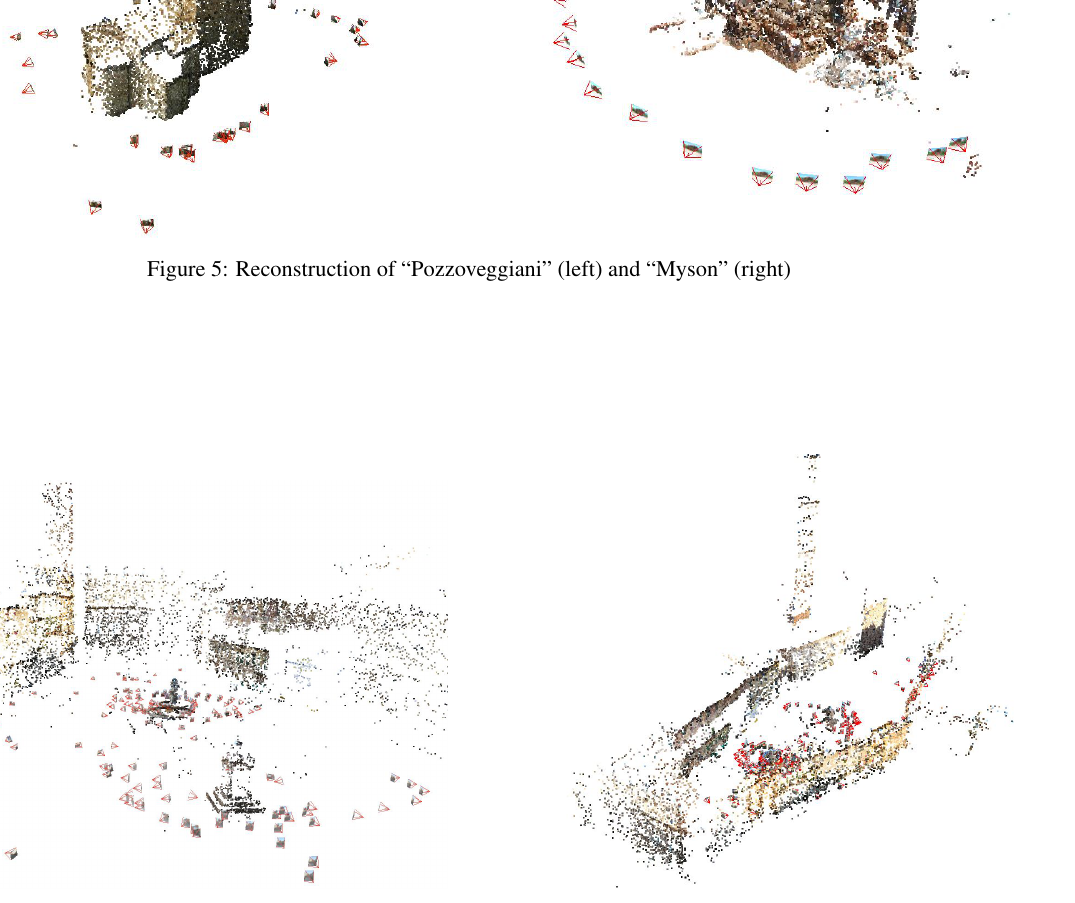
Figure 6: Two views of the reconstruction of “Piazza